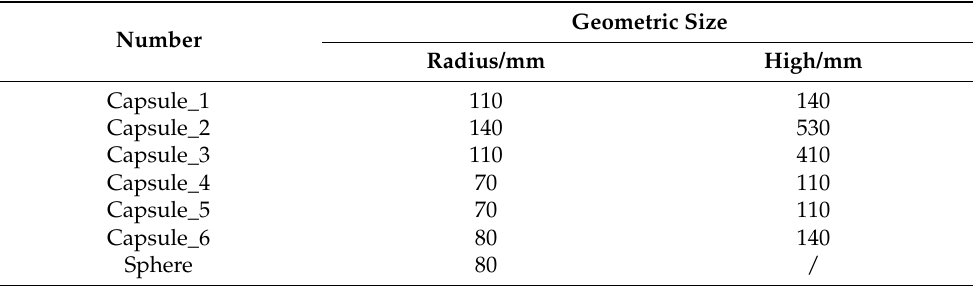
Table 2. Bounding volume